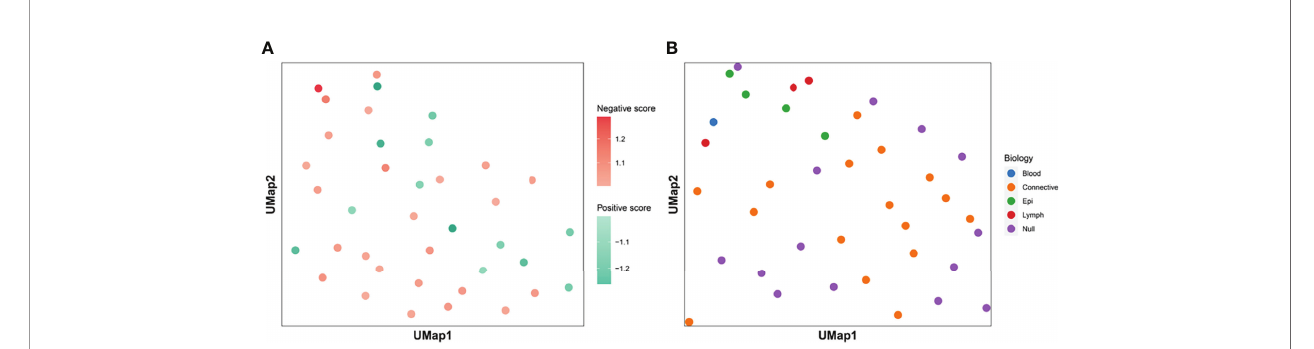
FIGURE 3 | Clustering centroids. We showed the centroids of the 38 features. Panel (A) shows the effect of all features on the treatment effect. Darker red means that the feature has a greater signi fi cance of having a positive effect on immunosuppressive treatment. The darker the blue color, the greater the signi fi cance that the feature plays a negative role. Panel (B) shows the biological signi fi cance of all the features. The features dominated by muscle and connective tissue are distributed in the same area. Features which were clustered by shape were distributed in the periphery. The centers of epithelial and lymphocyte-dominated features were also close to